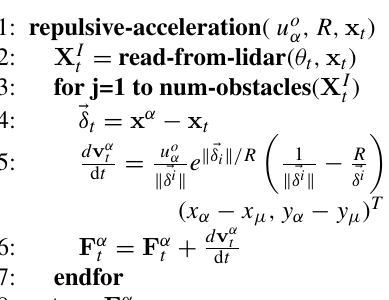
Table 7 Algorithm Repulsive accelerative